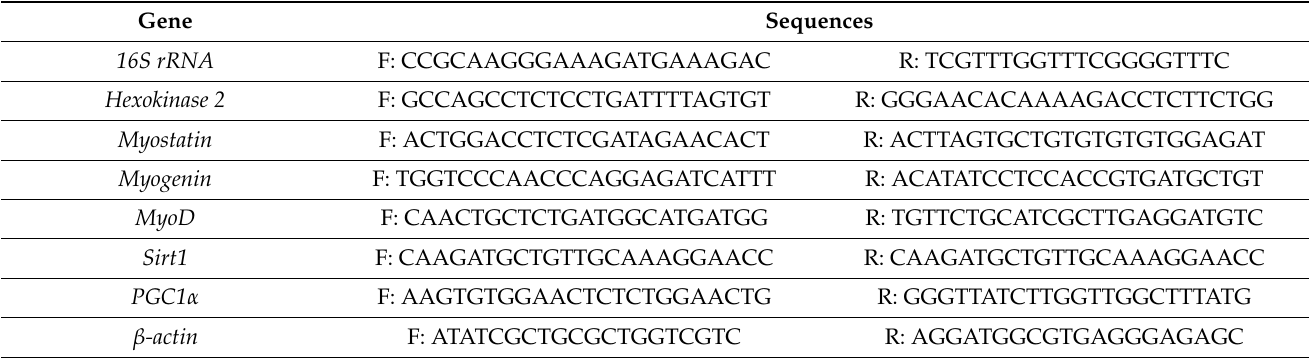
Table 1. The oligonucleotide primer sequences used in